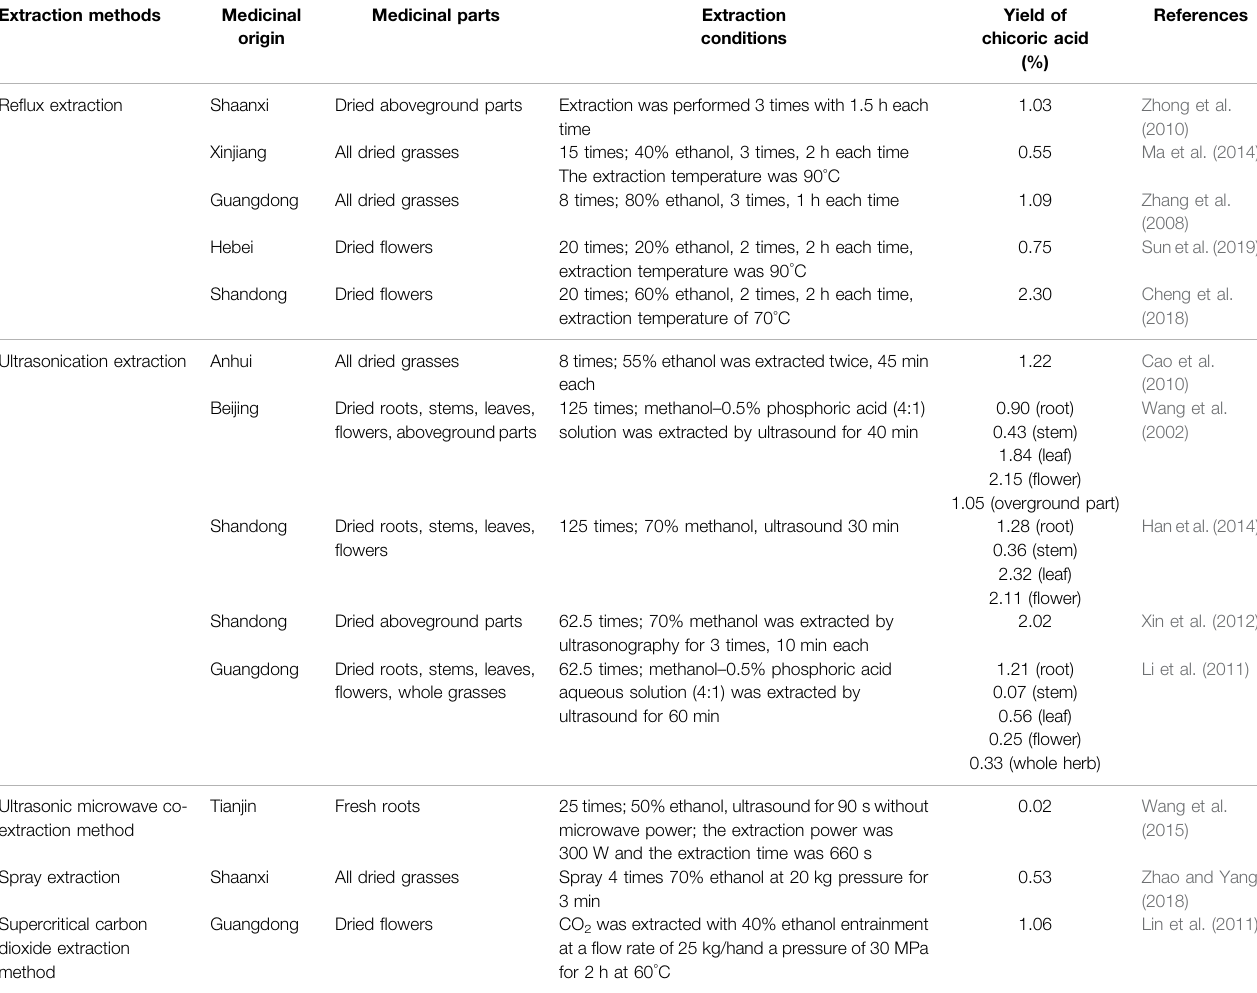
TABLE 2 | Comparison of chicoric acid levels in Echinacea purpurea (L.)